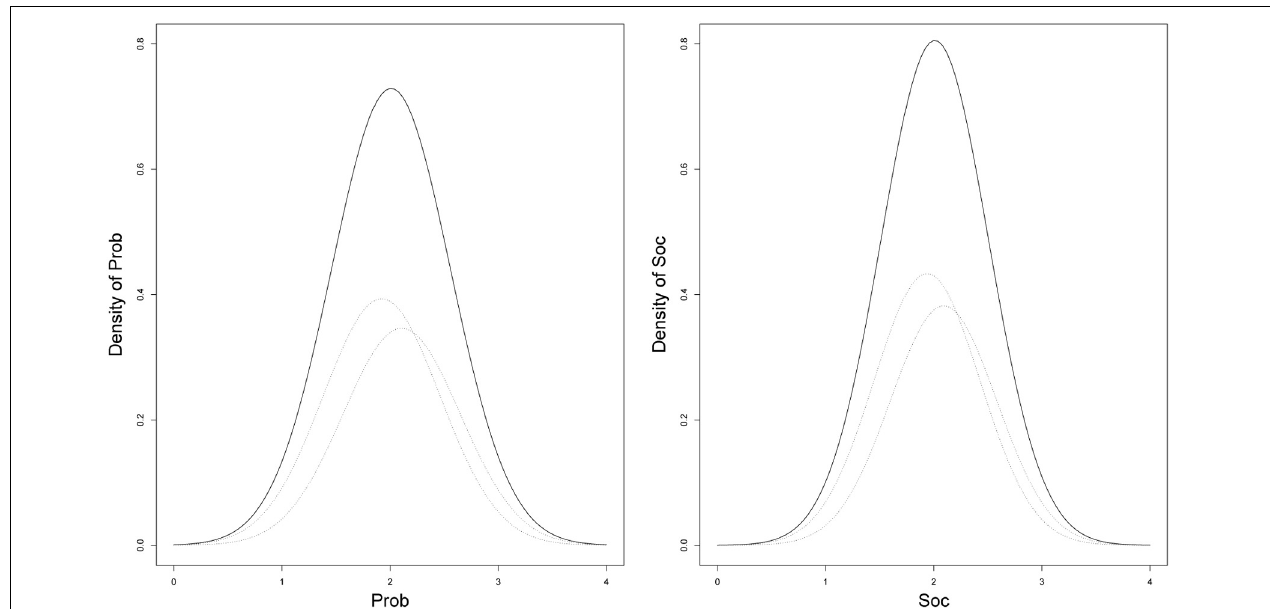
FIGURE 9 | Predicted slightly non-normal densities of the Level-2 predictors Prob and Soc obtained from a two-class